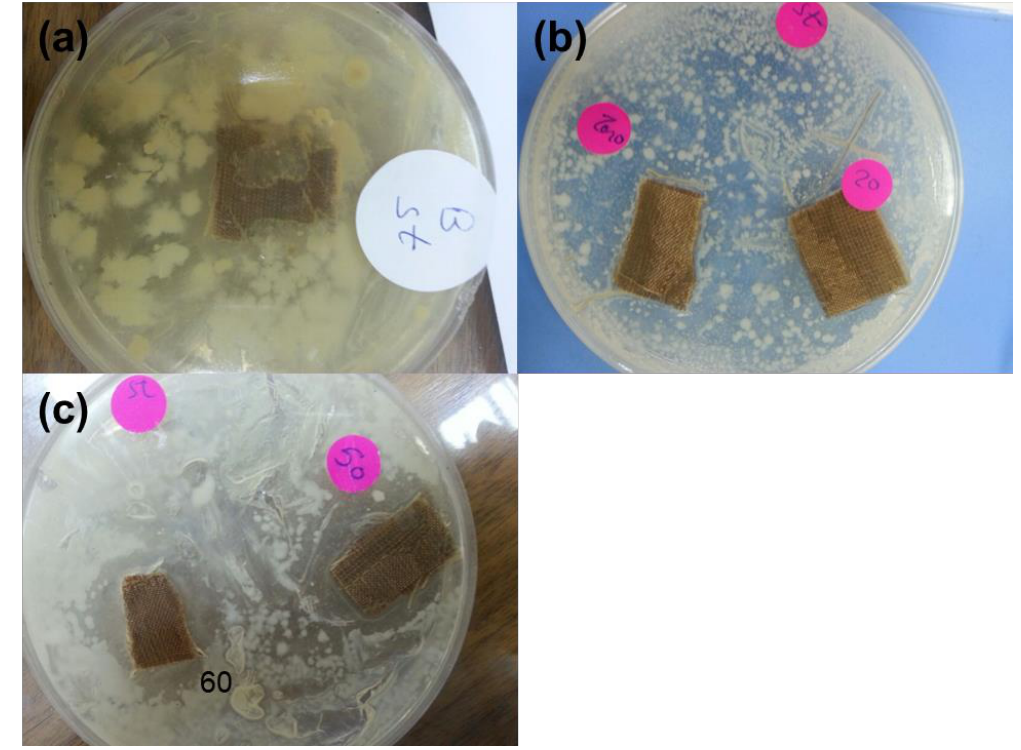
Table 5. Antibacterial zone of untreated and treated textile fabrics.